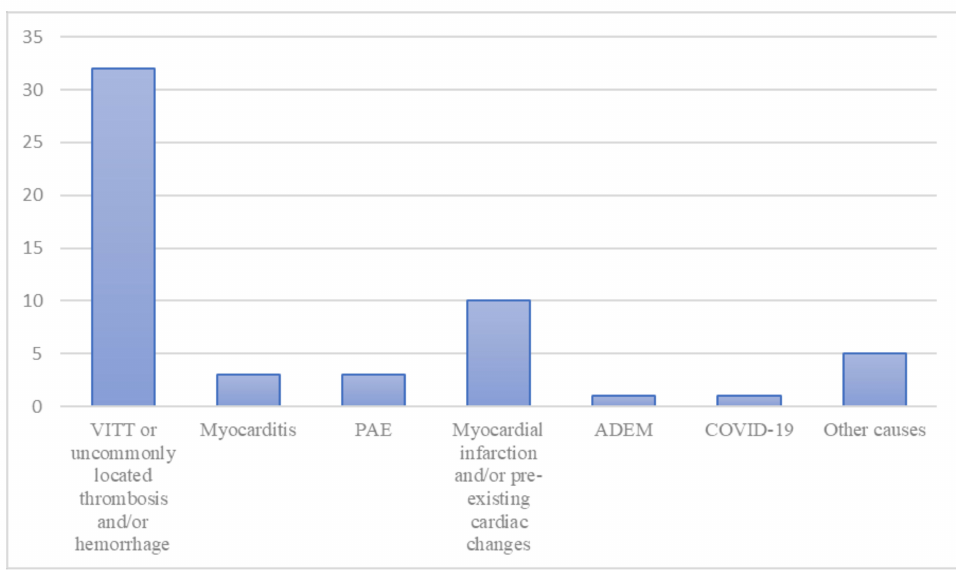
Figure 2. The distribution of the cause of death among the cases. “Other causes” includes one case of massive cerebral hemorrhage not associated with thrombosis or auto-antibodies, one case of anaphylactic reaction to anesthetics associated with cerebral venous sinus thrombosis and anti-PF4 antibodies, one case of hyperglycemic coma, one case of hemorrhagic shock due to aortic dissection and rupture, and one case of death due to the complications of rhabdomyolysis. ADEM indicates acute disseminated encephalomyelitis; COVID-19, coronavirus disease 2019; PAE, pulmonary embolism; VITT, vaccine-induced immune thrombotic thrombocytopenia.